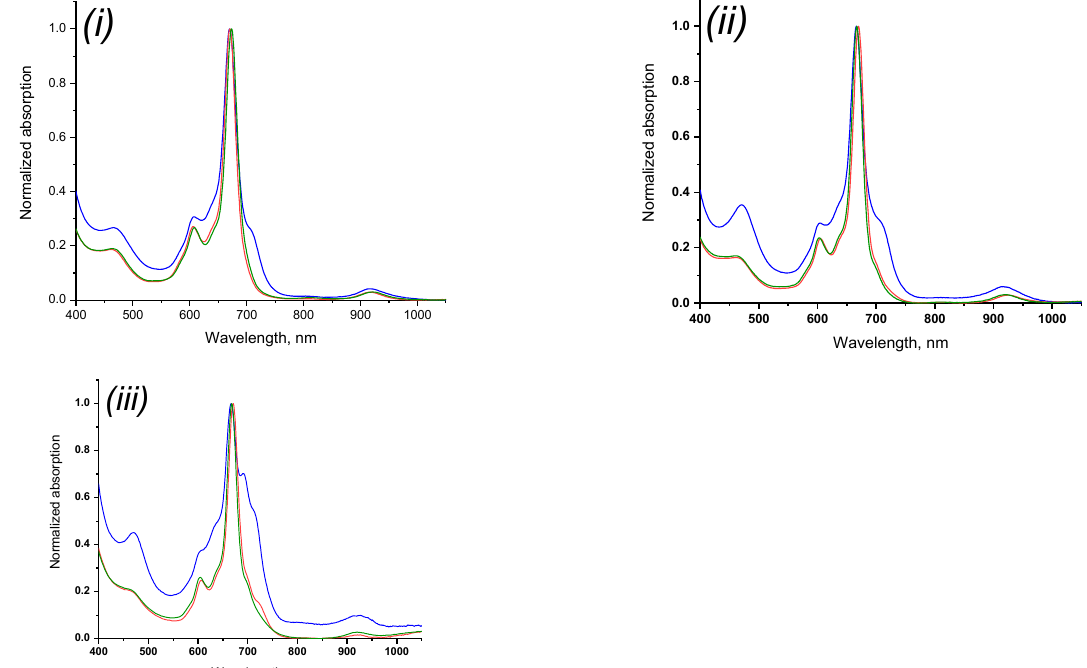
Figure 5. Normalized electronic absorption spectra of 3 ( i ), 4 ( ii ) and 5 ( iii ) in acetone (blue curve), THF (red curve), chloroform (green curve). Table 1. Spectroscopic characteristic of rare-earth double-decker bistetrakis-4-[3-(3,4-dicyanophenoxy)phenoxy]phthalo- cyanine complexes in organic solvents.